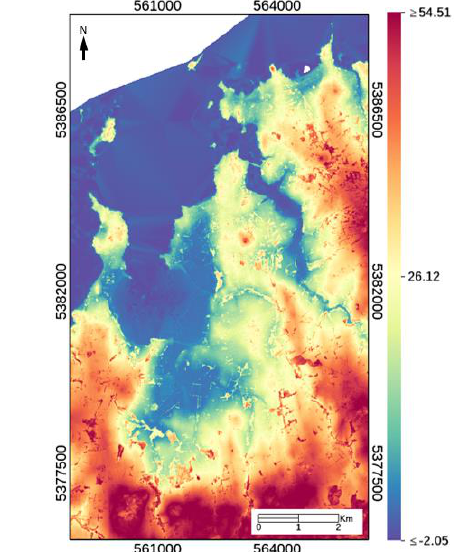
Figure 4. (A) Scatterplot of LiDAR vertical validation and Pleiades-1 Digital Surface Model (DSM); (B) Pleiades-1- derived DSM (altimetric reference is RAF18 in m) and